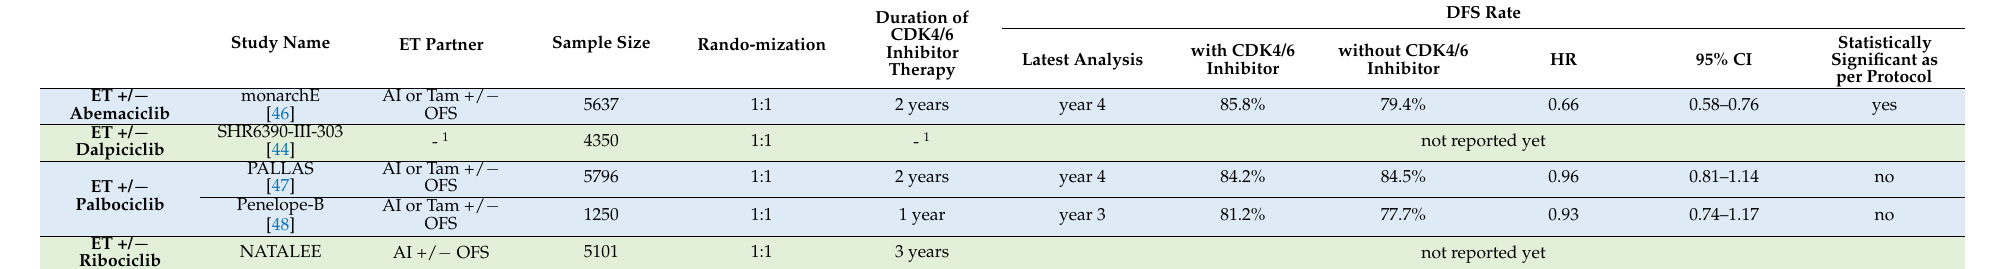
Table 2. Efficacy of CDK4/6 inhibitors in hormone receptor-positive, HER2-negative eBC phase III trials at the latest analysis (in alphabetical